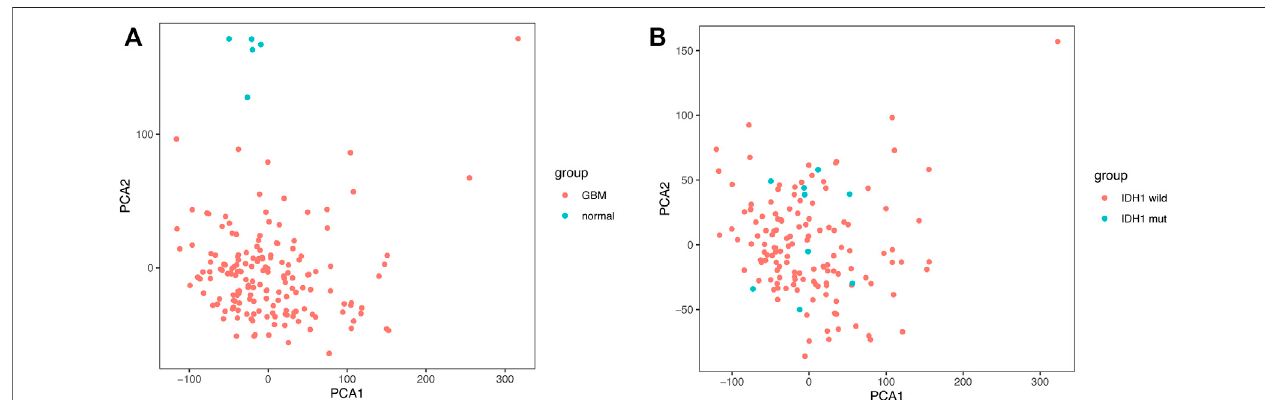
Frontiers in Pharmacology |